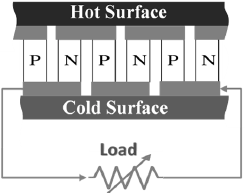
Figure 1. Schematic of the construction and working of a TEG.